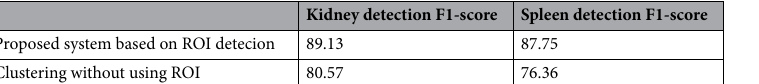
Kidney detection F1-score Spleen detection F1-score